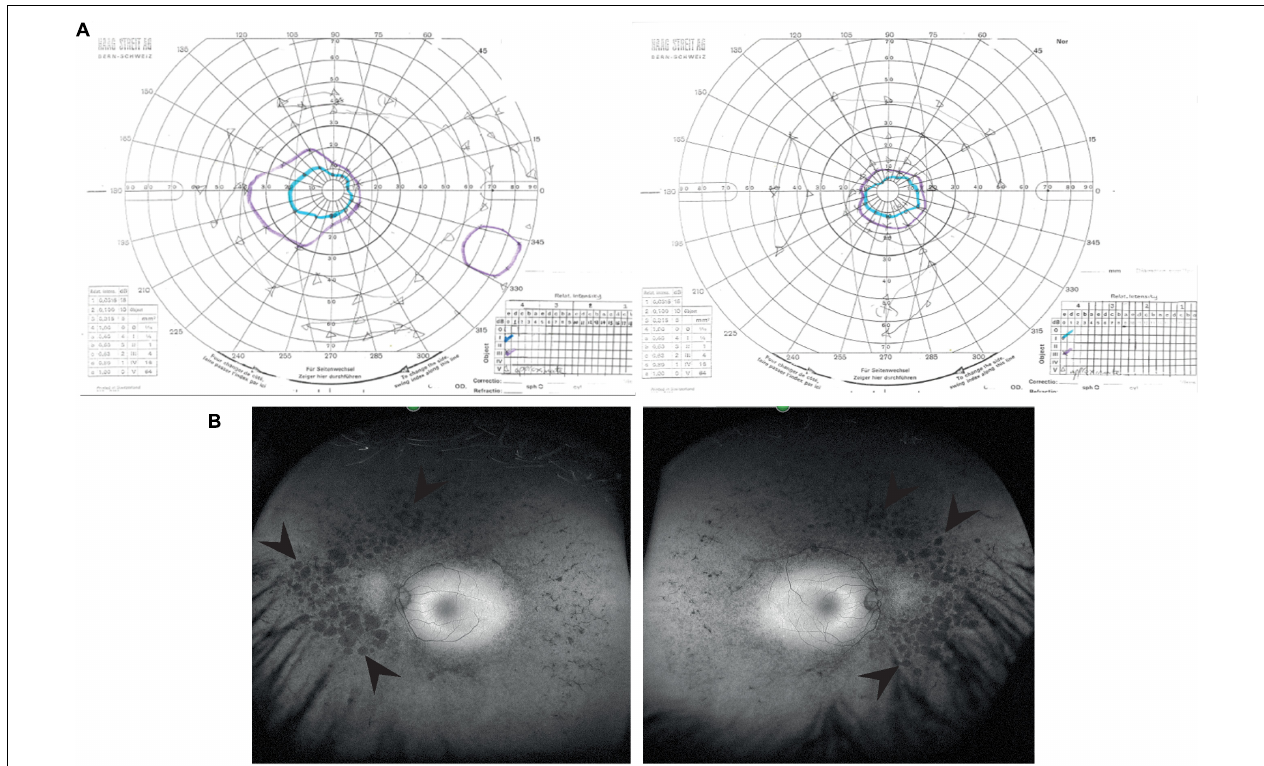
FIGURE 1 | Clinical characteristics of patient at visit in 2017. (A) Goldmann visual field images show bilateral tunnel vision with a small island of peripheral vision in the right eye. Both the I4e (turquoise line) and III4e (purple line) targets were used to plot the visual fields. Using the commonly used III4e target in both eyes, the visual fields extend from 10 degrees temporally to 40 degrees nasally along the horizontal and 15 degrees above and below fixation in the right eye with a peripheral island of vision in the inferotemporal quadrant. The peripheral fields in the left eye are constricted to the central 15 degrees. (B) Red-free fundus photographs show extensive bilateral retinal pigment disruption. Arrowheads point to areas of pigment defects in the periphery of the fundus for both eyes. Areas of defects are larger and more confluent in the nasal compared to temporal periphery.